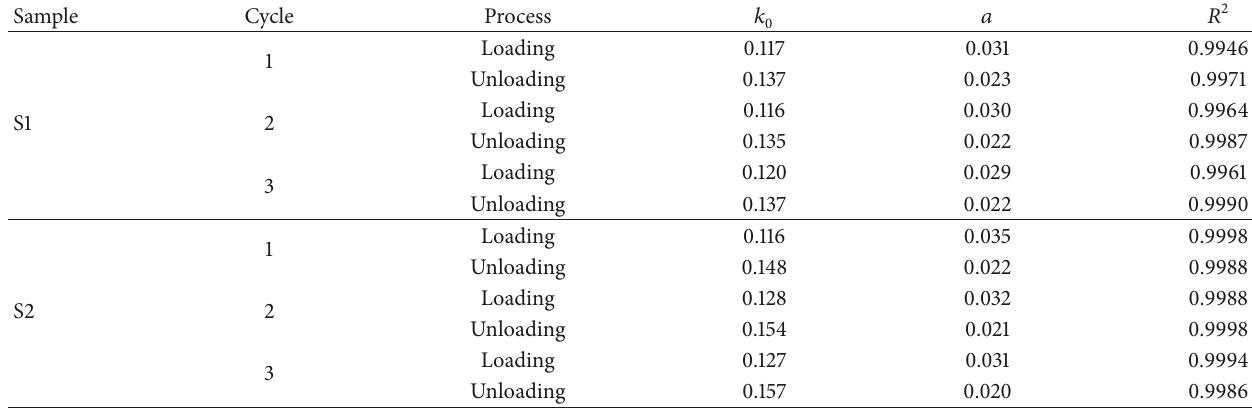
Table 2: The fitting parameters in the mathematical models describing the relationship between permeability and injection pressure. Sample Cycle Process 𝑘